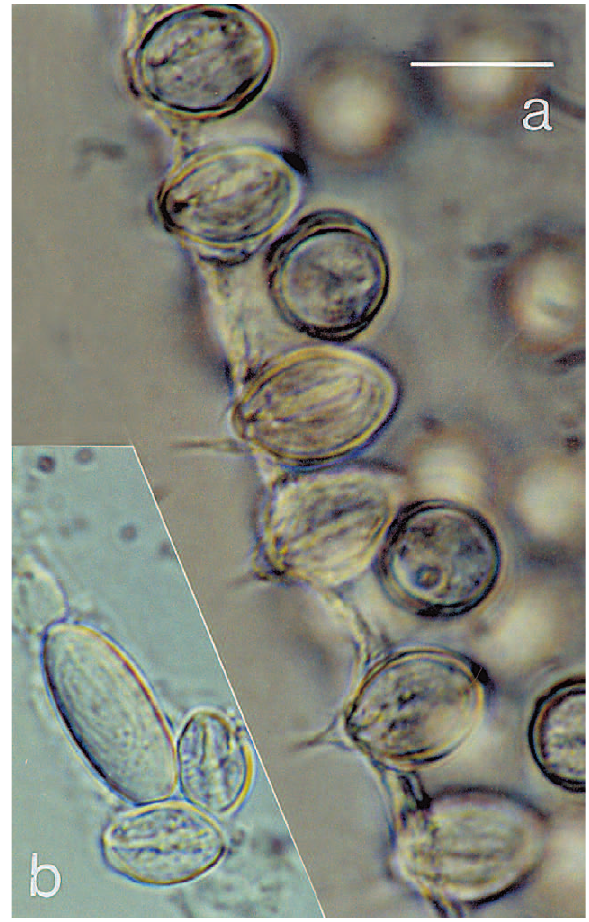
F IG . 6. – Sarsia bella; a. enlargement of box insert from Figure 5: magnified: part of bell of young medusa with group of microbasic p mastigophores photographed at kink of exumbrella, unexploded ; b. hydroid: large isorhiza with 2 adjacent stenoteles. Scale a,b = 10